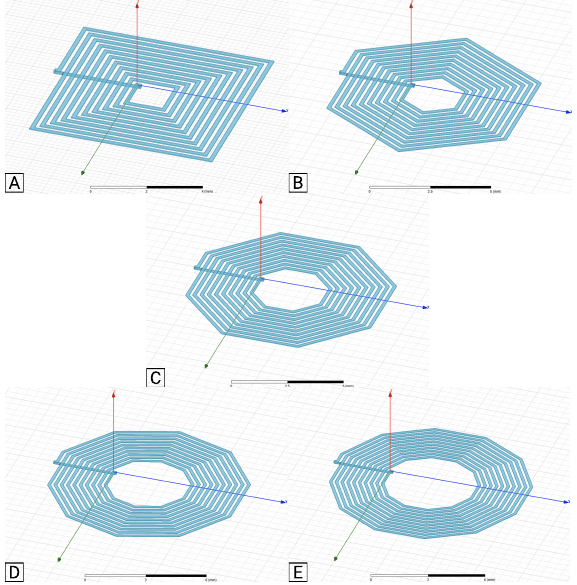
Figure 5. 1-layer coil layouts simulated in Ansys Software. Segments per turn: ( A ): 4; ( B ): 6; ( C ):